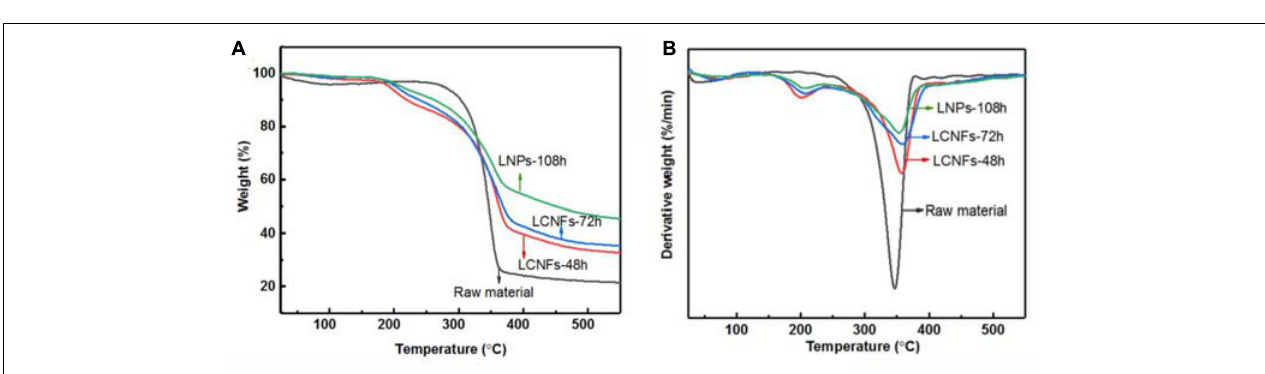
FIGURE 4 | TG (A) and DTG (B) curves of LCNFs-48 h, LCNFs-72 h, LNPs-108 h, and raw material.